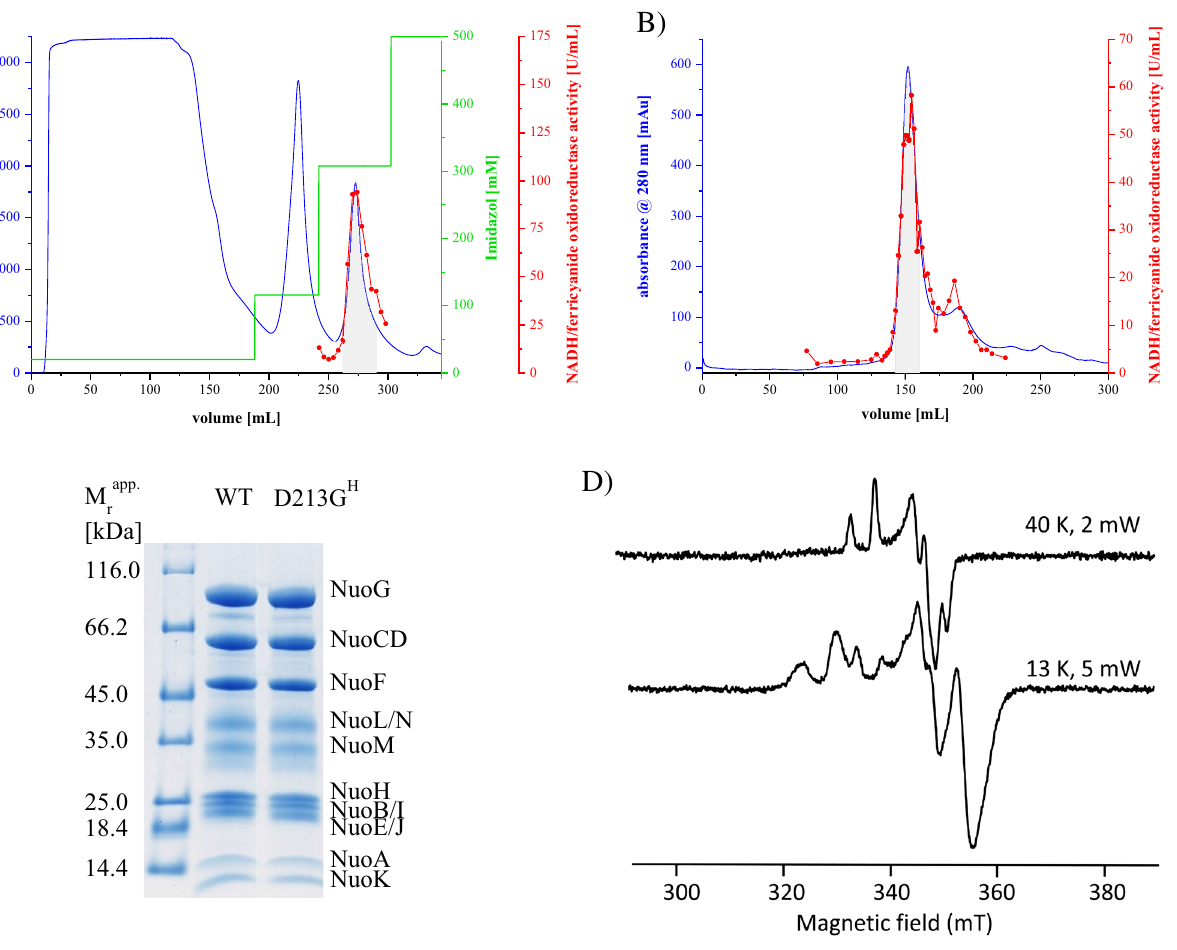
Figure 5. Preparation of complex I and the D213G H variant. Elution profile of ( A ) the affinity-chromatography on ProBond Ni 2+ -IDA and ( B ) the size exclusion chromatography on Superose 6. Fractions indicated with a grey background were used in the next step. Preparations of the wild type and the variant showed virtually identical elution profiles. ( C ) SDS-PAGE of both preparations revealing the presence of all complex I subunits. The faint band at around 80 kDa is a proteolytic digestion product of NuoG. ( D ) EPR spectra of the preparation of the D213G H variant reduced with NADH at 40 K and 2 mW (top), 13 K and 5 mW (bottom).